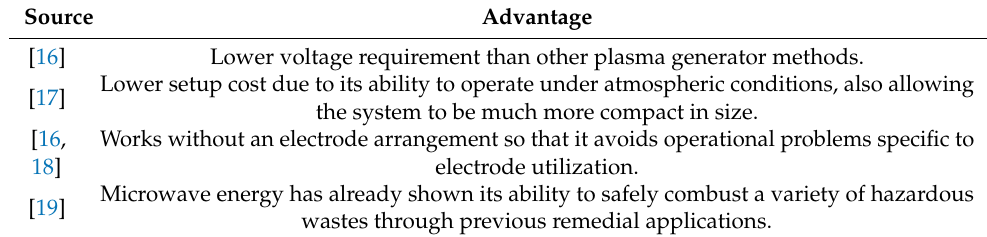
Table 1. Advantages of MW plasma gasification systems.